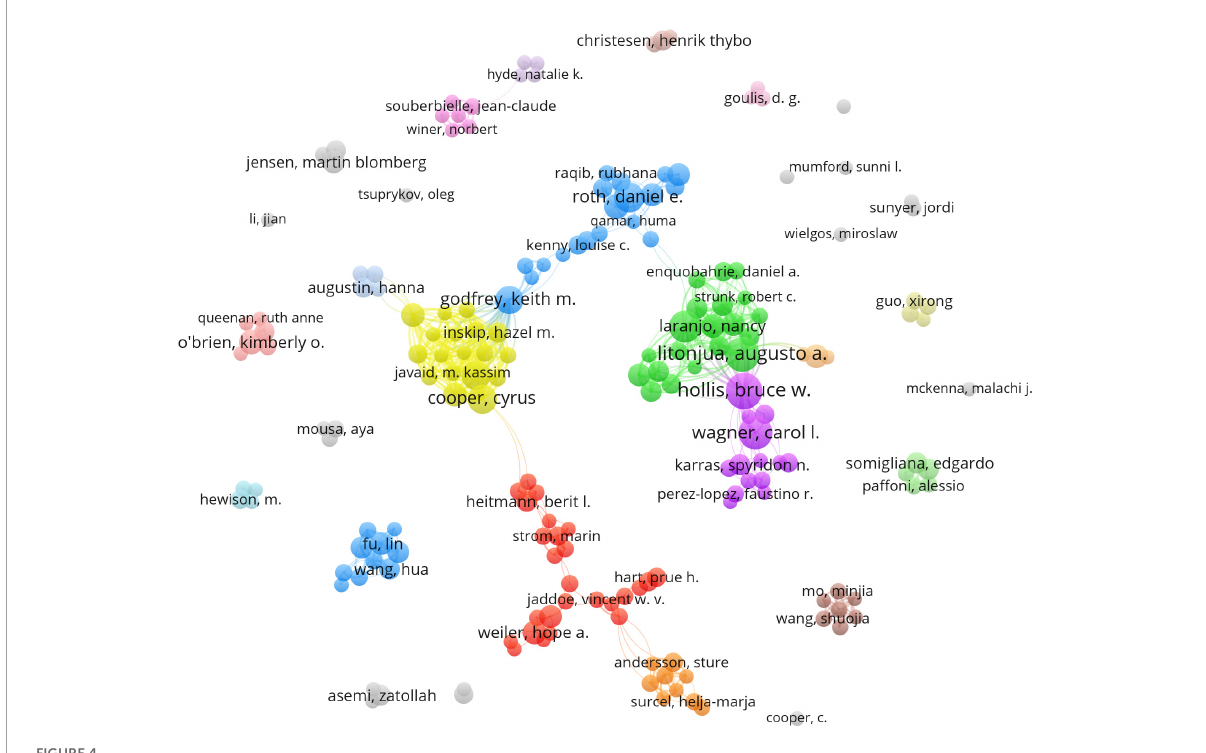
FIGURE4 Network map of co-authorship between authors with more than four publications.